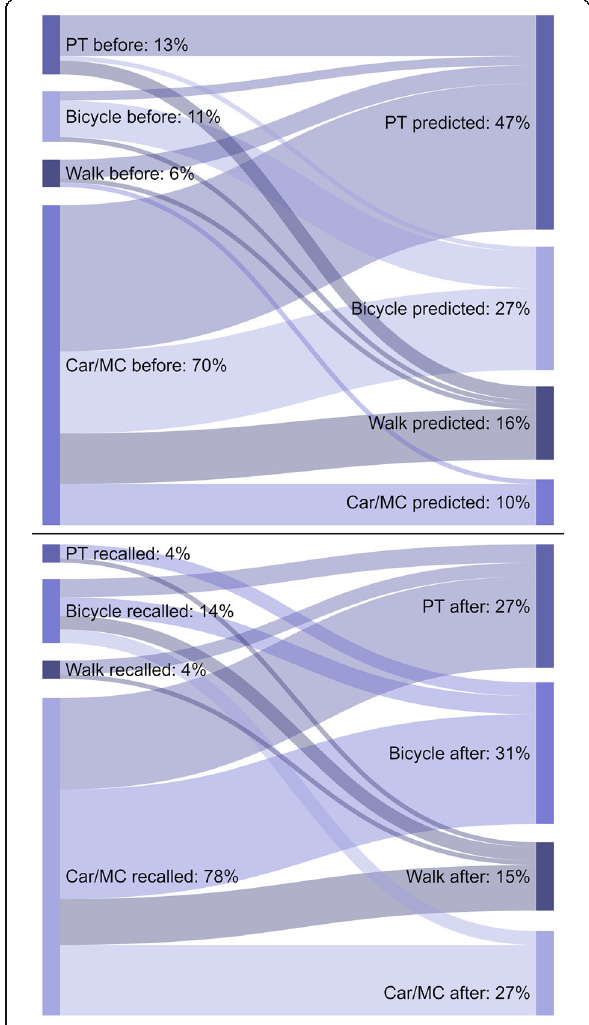
Fig. 3 Sankey diagrams showing the modal split of employees at Adresseavisen. Upper panel: mode pre-relocation and predicted post-relocation mode ( n = 90). Lower panel: recalled pre- relocation mode and actual post-relocation mode ( n = 78) (Note PT: Public transport, MC: